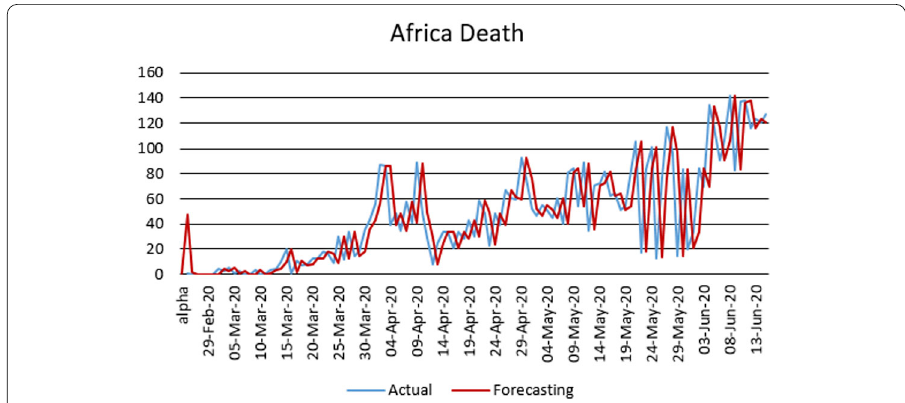
Figure 8 Exponential smoothing for deaths in Africa